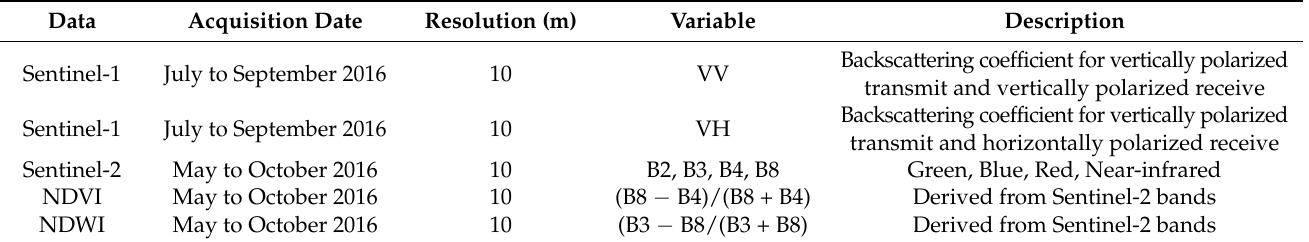
Table 1. Multisensor satellite data and spectral reflectance indices were used for supervised classifica- tion to identify the water bodies in the study